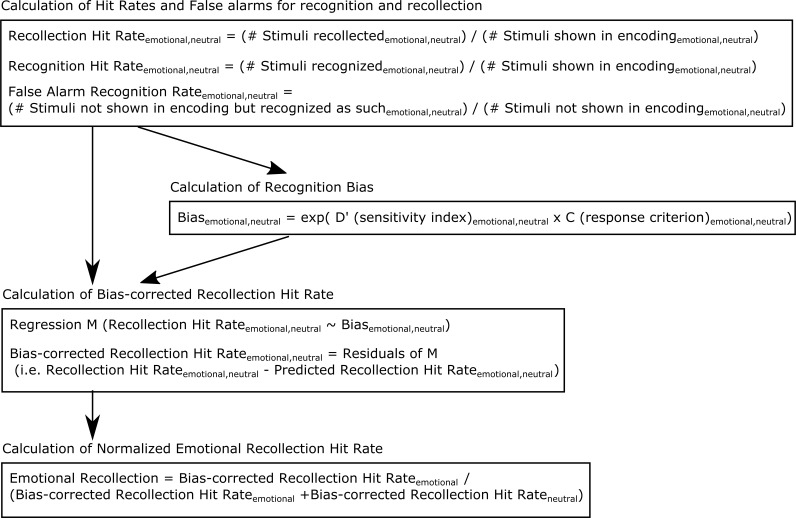
Schematic representation of the procedure used to calculate bias-free emotional recollection scores.Note: Recognition – and hence the recognition bias - was based on the correct or incorrect recognition of faces. Recollection involved the identification of the name belonging to the face (see also Figure 1). The work flow depicted here visualizes the calculation of the normalized emotional recollection scores used in the manuscript. Terms with ‘emotional, neutral’ in subscript refer to a separate calculation for emotional and neutral with the provided formula.